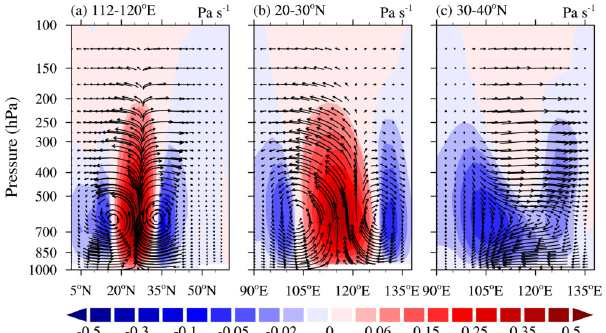
Figure 8. Composite (a) Q 1 (shading, unit: Kd − 1 ) and variance (dashed contours, unit: %) at 500hPa for the 13 SR–NH events, and (b) for the composite vertical profile of the average Q 1 value over the domain 20–30 ◦ N, 110–120 ◦ E. Dotted white regions indicate areas at the 95% confidence level based on the two-tailed Student t test.